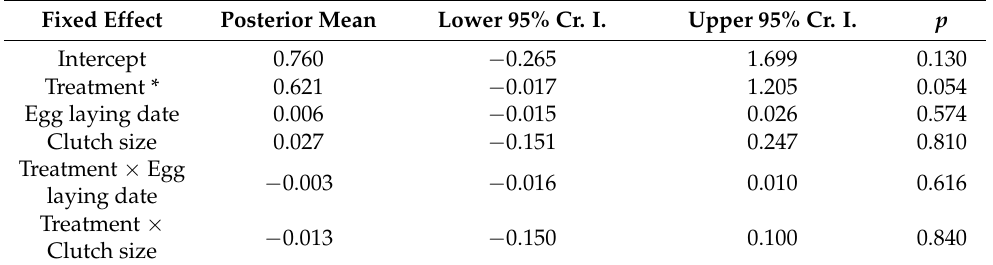
Figure 3. Percentage of egg rejection and/or nest sanitation performed by male and/or female barn swallows. (a) Mock egg + peanut shell trial: egg rejection and nest sanitation occur in a single nest. In this group either female or male performs both egg rejection and nest sanitation, or both sexes participate by each sex performing one of the behaviors (egg rejection or nest sanitation) without overlap. (b) Mock egg trial: only egg rejection occurs. In this group, both partners may cooperate to reject the mock egg. (c) Mock egg + peanut shell trial: only nest sanitation occurs. Numbers under bars indicate the sample size (i.e., number of nests). Table 2. Egg rejection probability of barn swallows following experimental treatments and egg laying date from generalized linear mixed models by Markov Chain Monte Carlo technique. Cr. I.–critical interval.